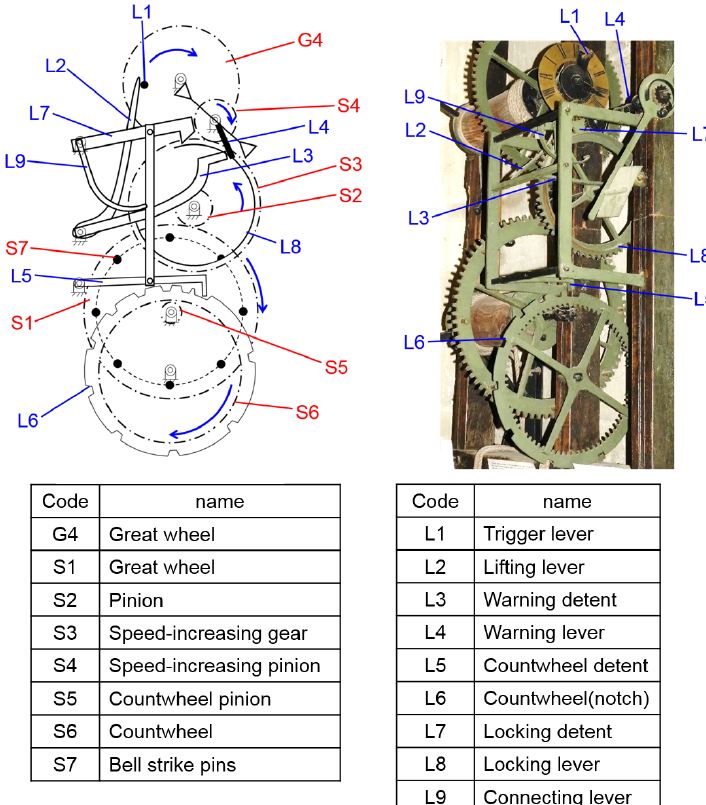
Figure 11. Striking train structure of the Kempsey clock (N6) (Chadclocks, 2018a).